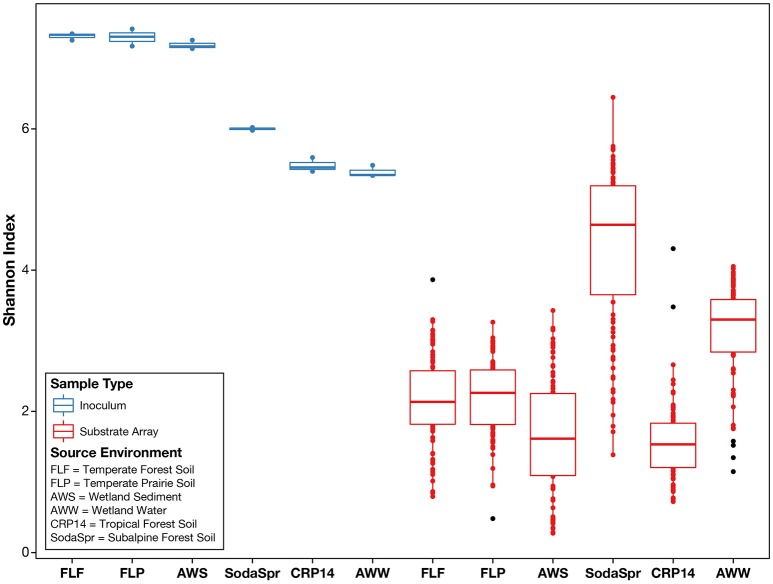
Alpha diversity of environmental inocula and EcoPlate enrichments as measured by the Shannon index of diversity. On average, the total diversity of environmental communities decreases substantially following incubation in the substrate array, regardless of carbon source.